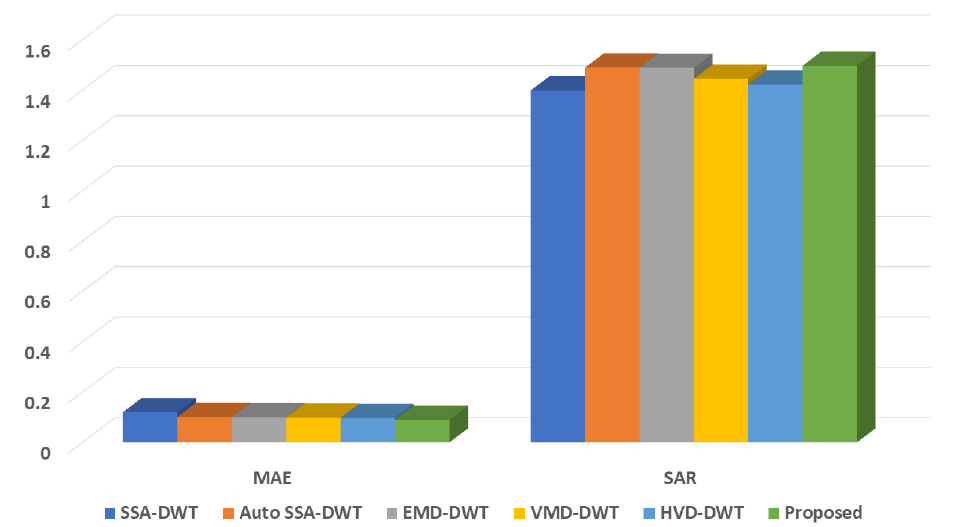
Figure 8. Comparison of MAE and SAR metrics with existing